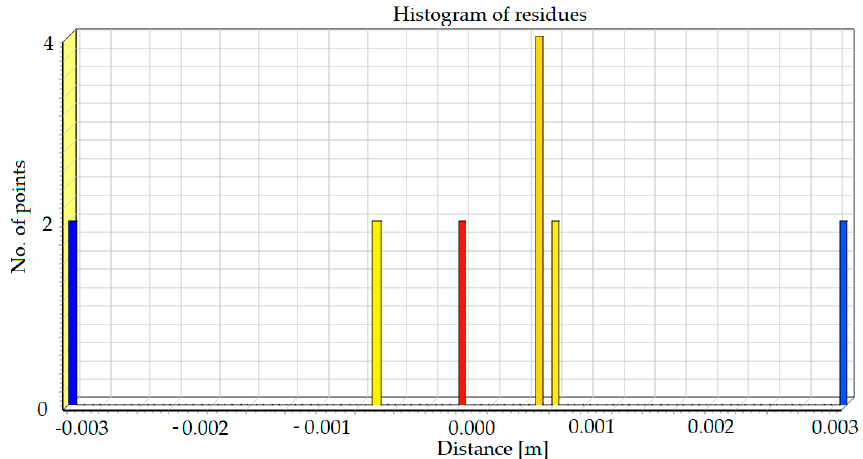
Figure 15. Histogram of residues which shows the precision of scan alignment.